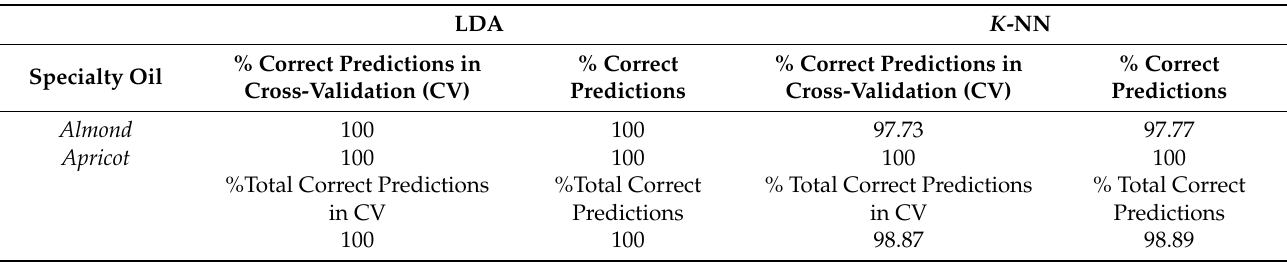
Table 4. Linear Discriminant Analysis (LDA) and K -Nearest Neighbors ( K -NN, k = 5) classification results on Almond and Apricot